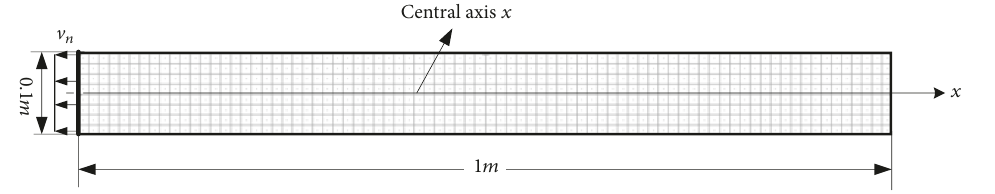
Figure 3: Mesh distribution of two-dimensional model.